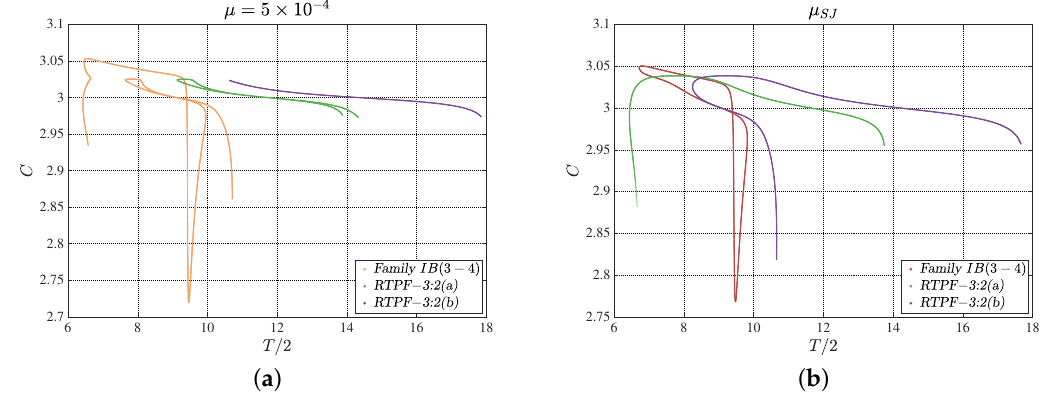
Figure 7. Characteristic curves of the family IB ( 3 − 4 ) and two RTPFs in the system for µ = 5 × 10 − 4 ( a ) and µ = µ SJ ( b